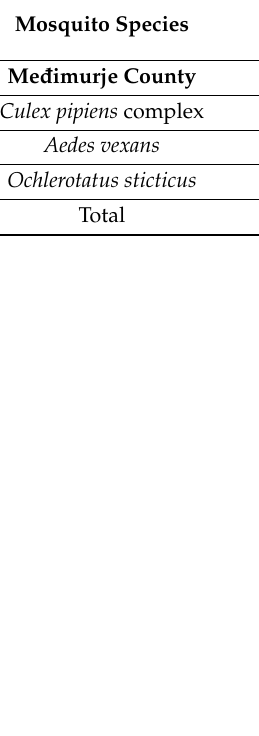
Table 3. Number of mosquito pools tested for the presence of West Nile virus and Usutu virus RNA by real-time RT-PCR. Mosquito